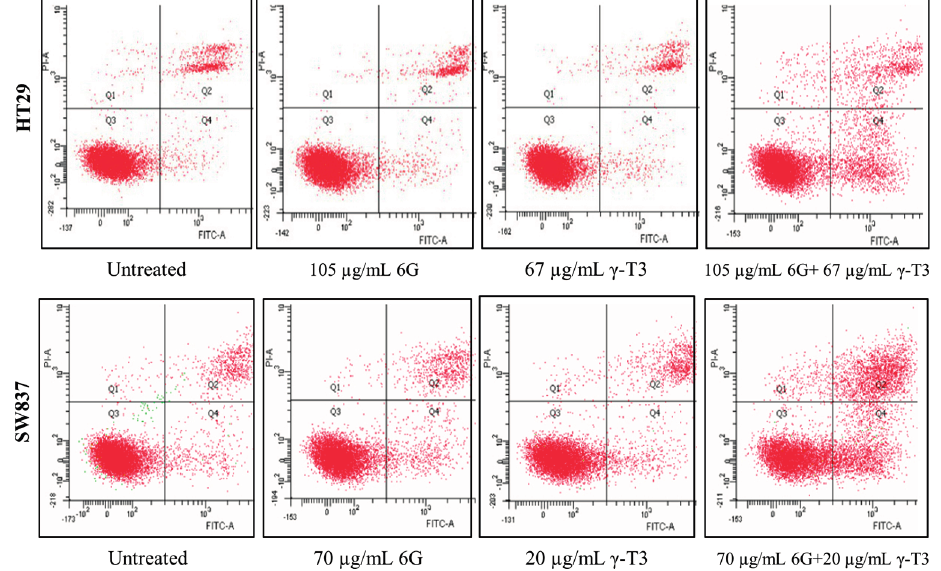
Figure 6. Effects of 6G, γ -T3 and 6G+ γ -T3 on both HT 29 and SW 837 cells. Apoptosis was quantified using flow cytometry. Q1 represents dead cells/necrosis, An − /PI+. Q2 late apoptosis, An+/PI+, Q3 viable cells An − /PI − , and Q4 early apoptosis, An+/PI − .